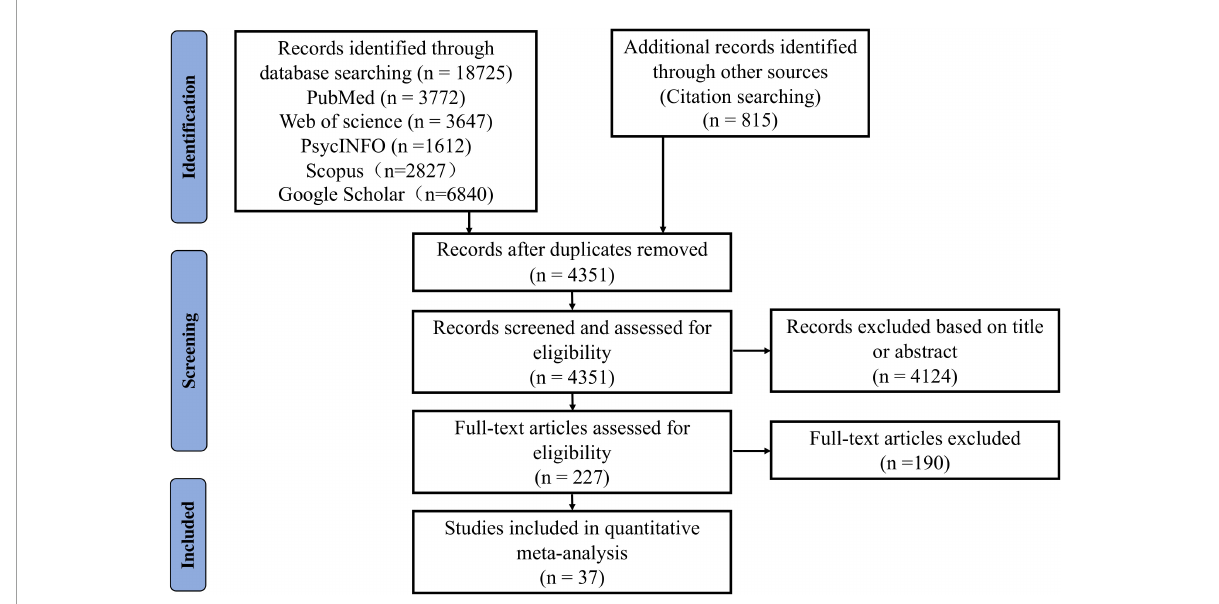
FIGURE1 The Preferred Reporting Items for Systematic reviews and Meta-Analyses (PRISMA) flow diagram of literature search and selection for the meta-analysis.